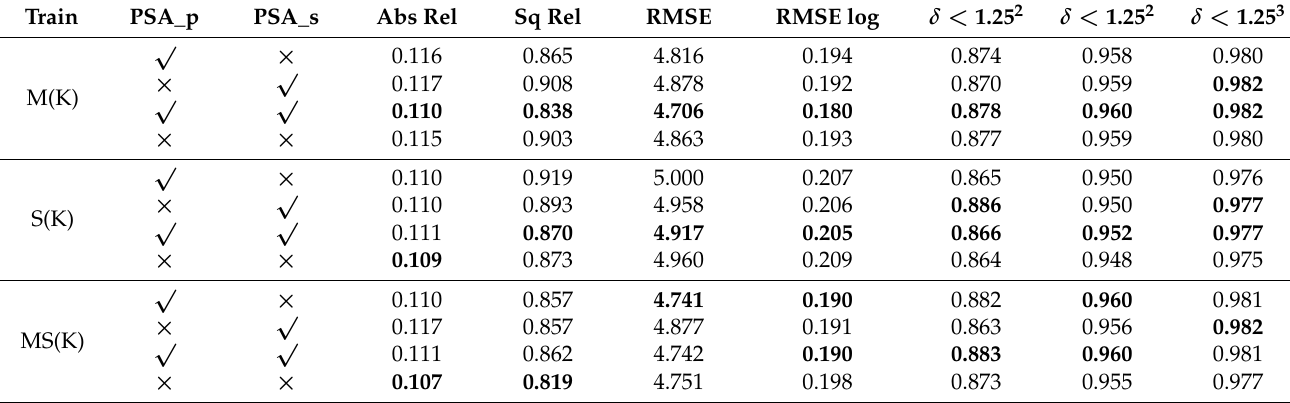
√ Table 3. Ablation study. : PSA module added, × : no PSA module added. If two forms of